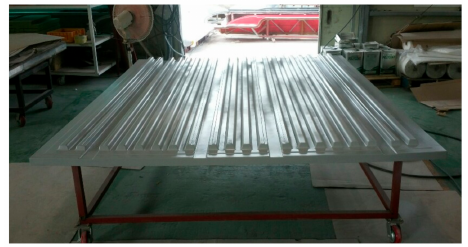
Figure 17. Final manufactured prototype.